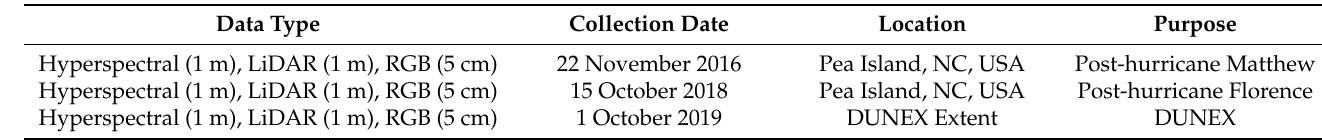
Table 1. Summary of CZMIL collection type, date, location and purpose in the North Carolina Outer Banks from 2016 to